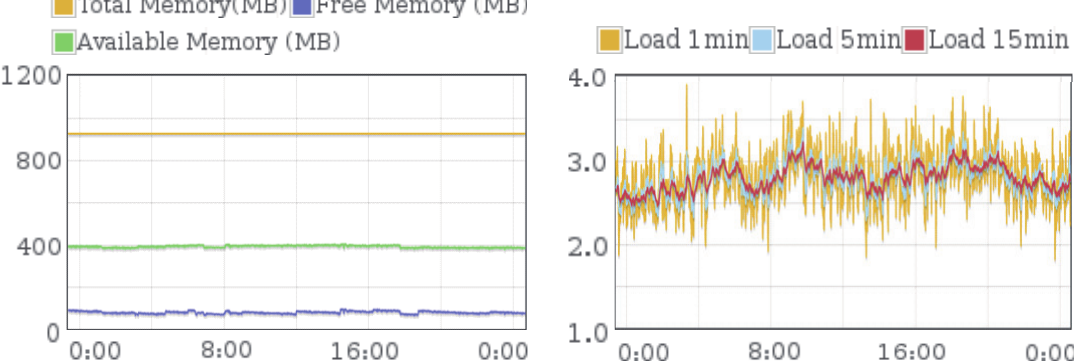
Figure 7. Usage status of system memory and CPU that collecting feature data using a Raspberry Pi.